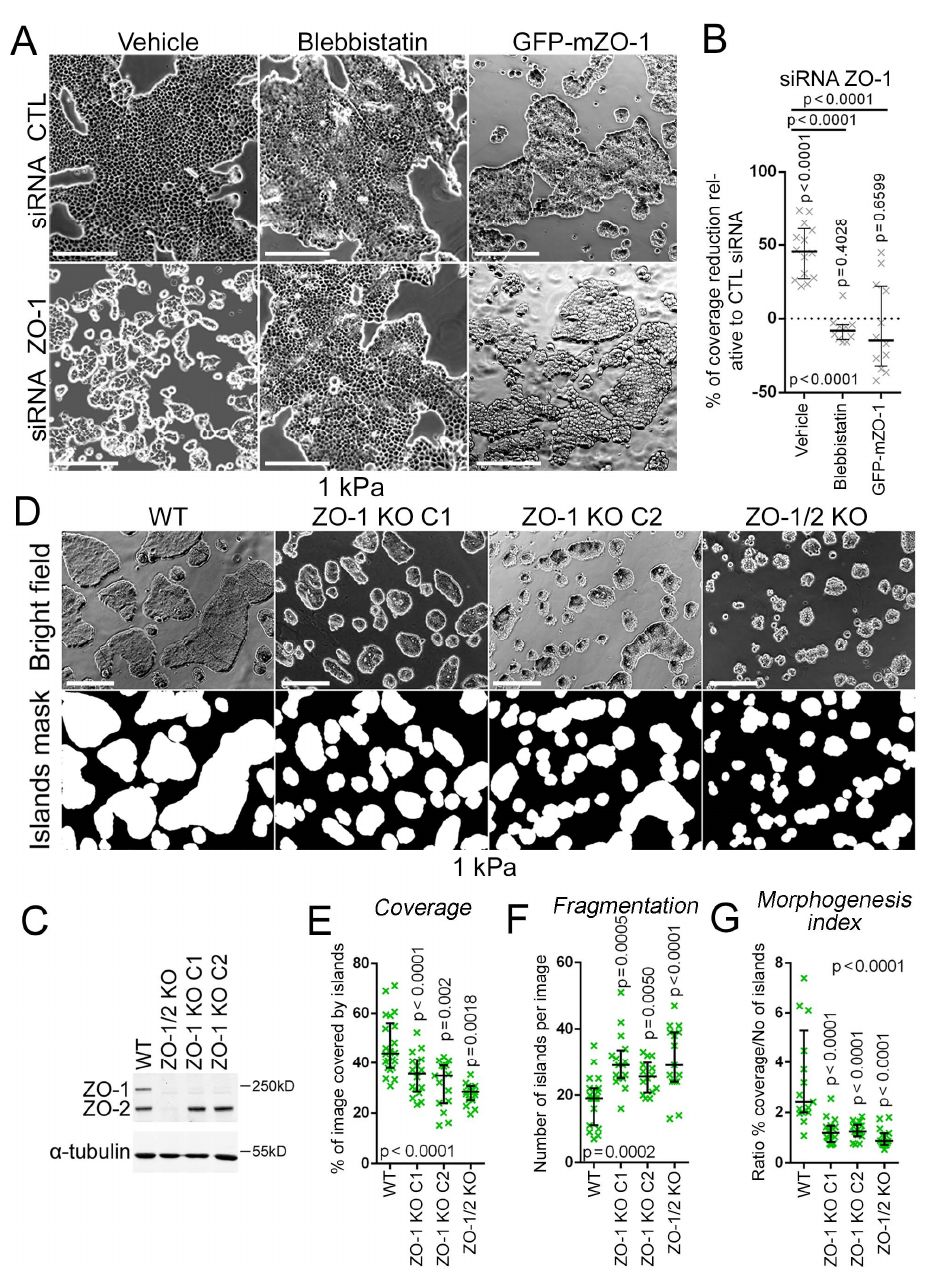
Figure 3. ZO-1 is required for epithelial morphogenesis on soft ECM. ( A , B ) siRNA-transfected MDCK cells were seeded on 1kPa hydrogels and treated with DMSO (vehicle) or blebbistatin for 24 h before bight-field microscopy imaging (( A ), left and middle panel). GFP-ZO-1 expressing cells were also transfected with siRNA and seeded on 1 kPa hydrogels before imaging (( A ), right panel). Percentages of area coverage of cell islands was measured (( B ), data points represent images). ( C – G ) Wild-type and knockout MDCK cells were analysed by immunoblotting ( C ) or were seeded on 1 kPa hydrogels before bright-field microscopy imaging and binary segmentation of cell islands ( D ). Area coverage by cell islands per image ( E ), the number of islands per image as a measure of frag- mentation ( F ), and the morphogenesis index consisting of the ratio of both parameters ( F ) were quantified. Data points represent images. Magnification bars, 200 μ m. AJ tension. Thus, substrate stiffness determines the impact of ZO-1 depletion on ten- sion acting on AJ. These data also indicate that the ZO-1 depletion-induced morphogene- sis defect on 1 kPa ECM was not due to increased cell–cell tension.